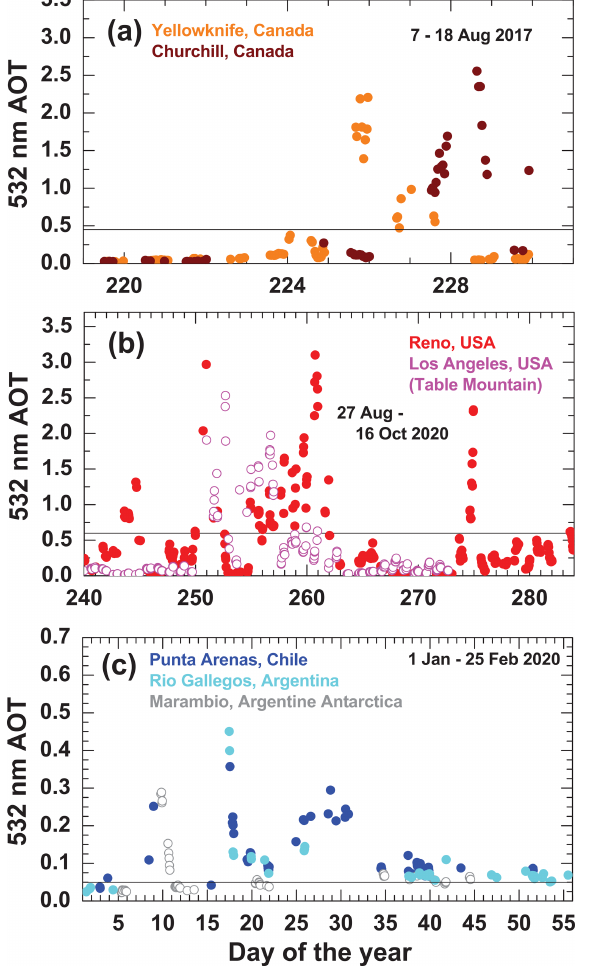
and 675 nm. We separately computed 532 nm AOT for fine-mode, coarse-mode, and total aerosol size distribu- tions by using respective fine, coarse, and total aerosol Ångström exponents. In Fig. 3, the total, i.e., fine-mode plus coarse-mode, AOT is shown. In all other figures below, we exclusively used the fine-mode AOT at 532 nm. In cases with a strong smoke occurrence, the fine-mode fraction is usually > 0 .